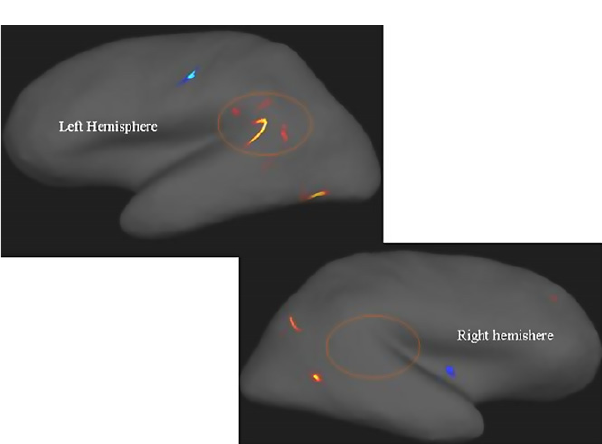
Figure 7. Areas with warm (red, yellow) colors show areas with reduced cortical thickness in patients with schizophrenia compared with healthy controls. Note the marked asymmetry in the peri-Sylvian region inside the circles. Areas in cold colors (blue) show increased thickness in the patients. Signifi cance threshold set to p < 0.001 with a cluster extension of at least 10 voxels. Neurological left-right display